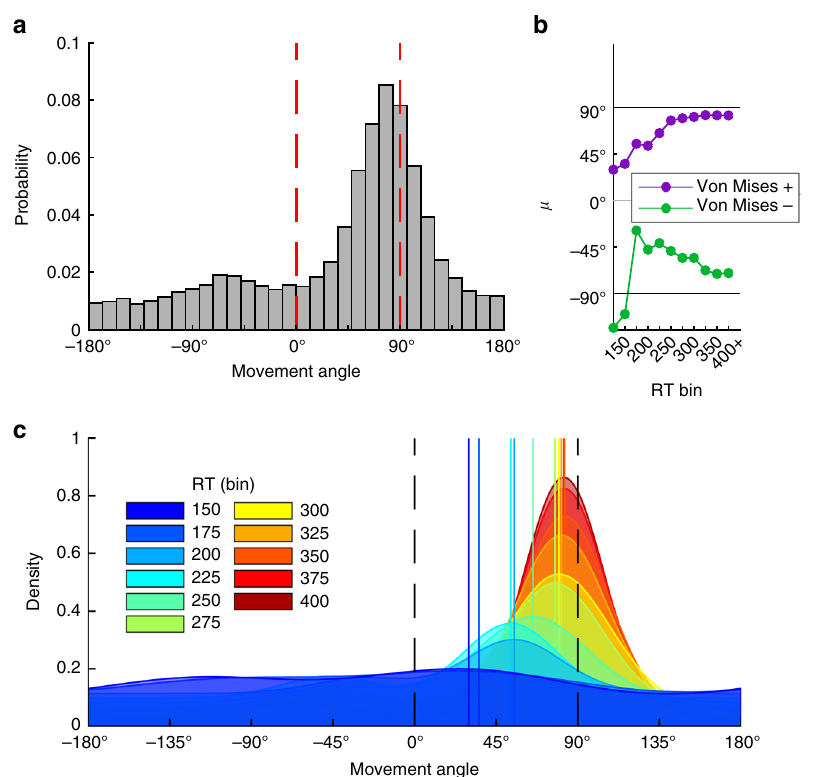
Fig. 5 FORCED task full data distribution and model fi ts. a Full distribution of movement angles across all RTs in the FORCED task. b Fitted mean parameters from the “ Free- µ ” mixture model (starting at the 150 ms bin) for directed reaches with a correct sign (Von Mises + , purple) and a fl ipped sign (Von Mises − , green). See Methods for model details. c PDFs of model fi ts in each RT bin (in ms). Vertical lines represent the fi tted mean parameter (Von Mises + ) for each corresponding RT result is consistent with a set size-dependent shift from a para- metric algorithm to a discrete retrieval strategy (Fig. 8c 15,27 ).